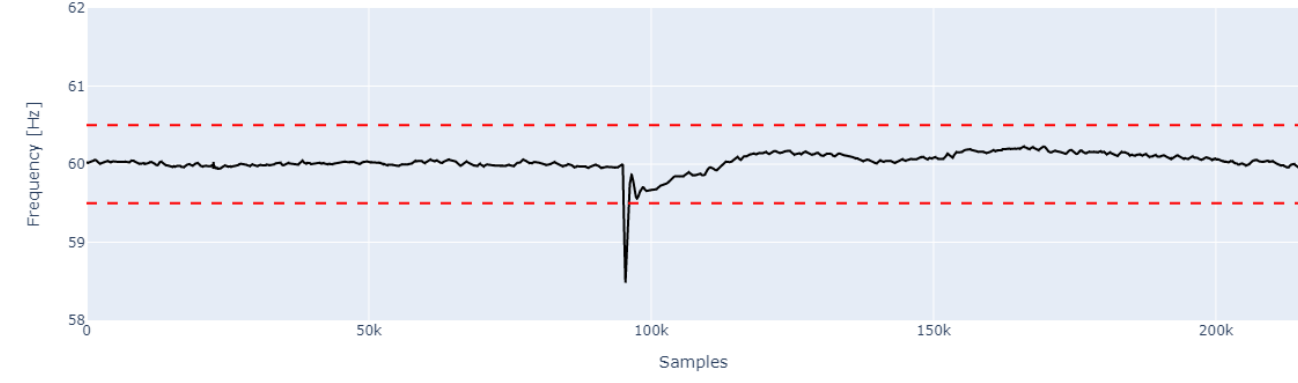
Figure 6. Event 1: frequency of PMU Cascavel Oeste (in the west of Parana State).